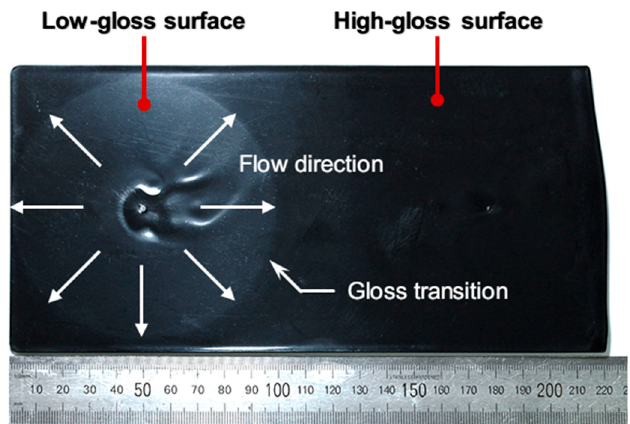
Figure 1. Example of the gloss defect on a high-gloss injection-molded surface.